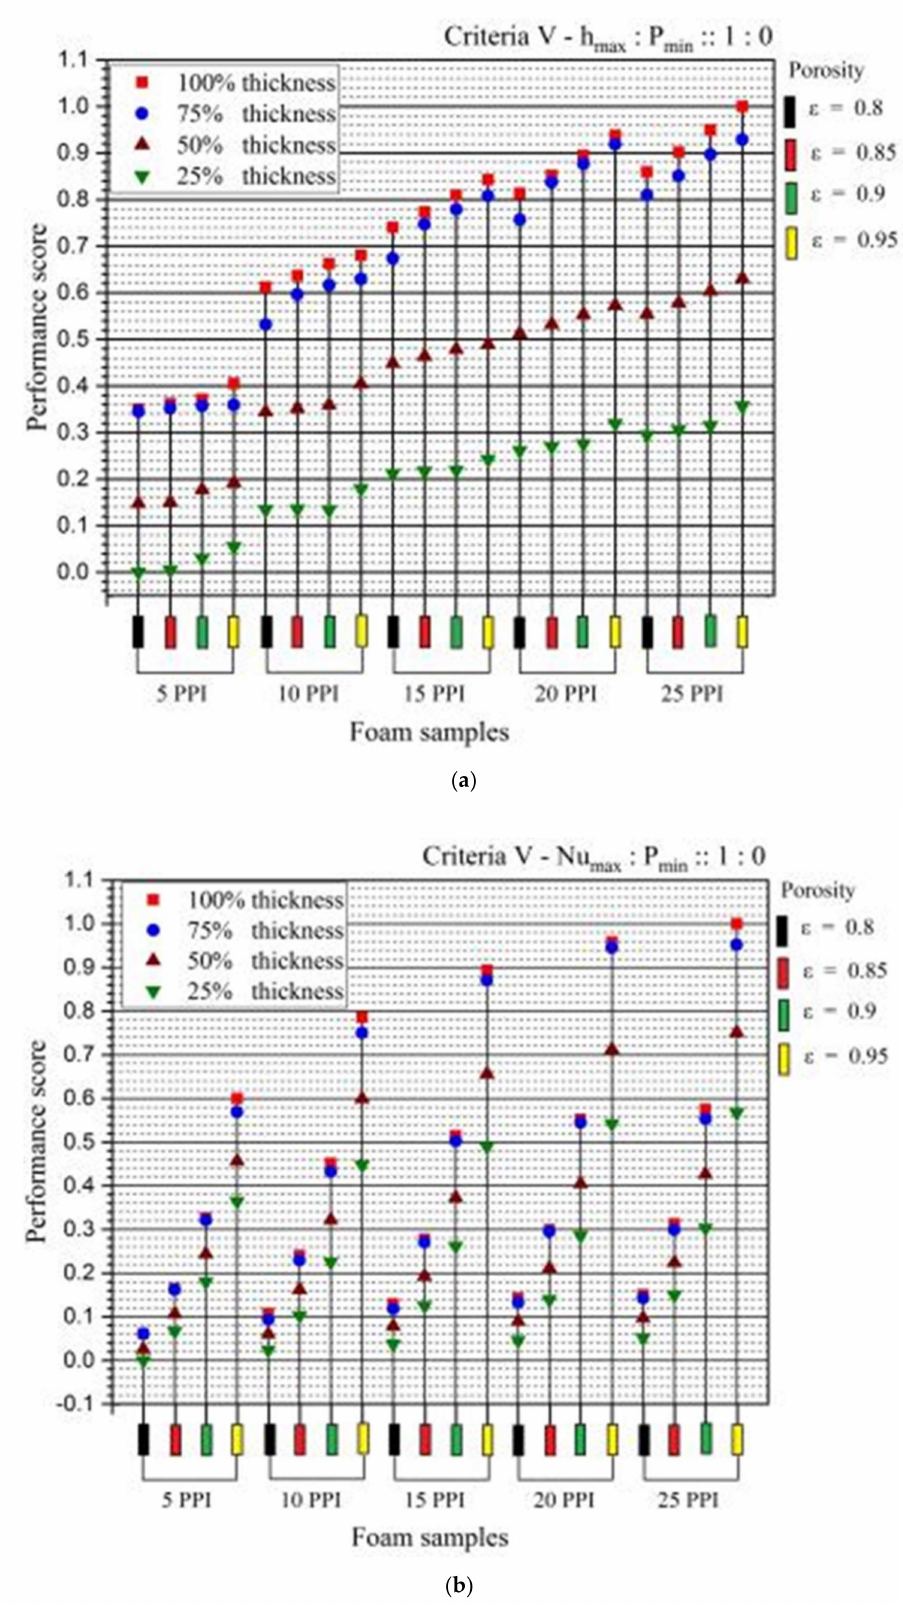
Figure 14. ( a ) Criteria V (h max :P min ). ( b ) Criteria V (Nu max :P min